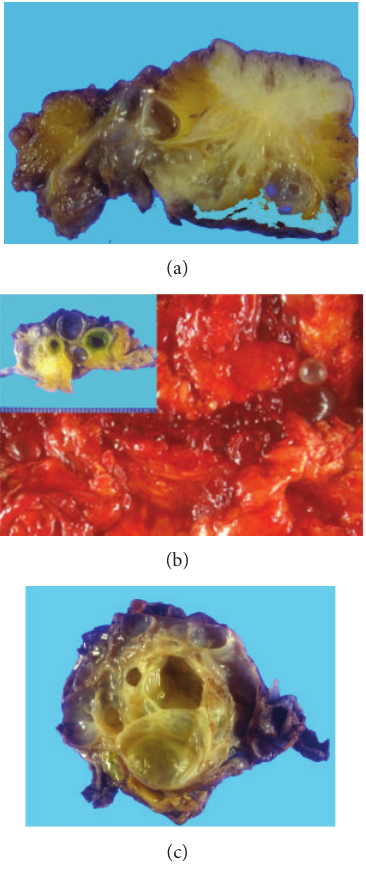
Figure 2: The multicystic mass surrounded to umbilicus (a), greater omentum (b), and mesentery of small bowel (c).